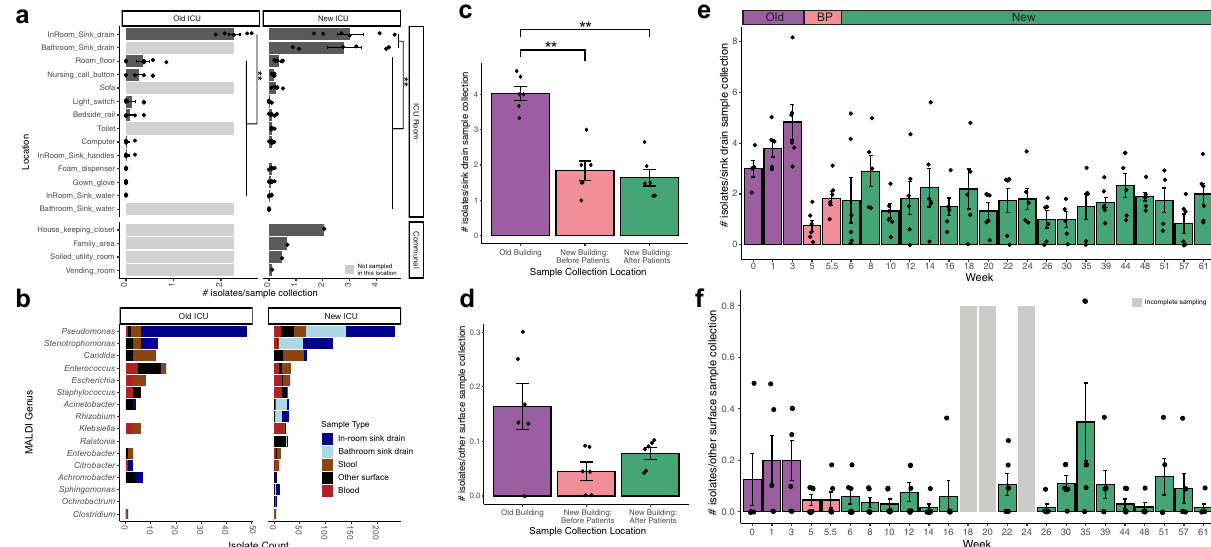
Fig. 2 Variation in isolate collection location, identity, and timing across all sampling. Error bars indicate standard error of intensive care unit (ICU) rooms. ** indicates generalized linear mixed-modeling (GLMM) p -value <0.01. a In-room and bathroom sink drains have signi fi cantly more isolates per collection than other surface locations in both the old and new ICU buildings ( n = 566 surface isolates). Locations in light gray were not collected in old ICU. b Genus of matrix-assisted laser desorption/ionization-time of fl ight mass spectrometry (MALDI-TOF) species identi fi cation of all collected isolates in both the new and old ICU. Other Surface includes all other surfaces that are not in-room or bathroom sink drain. c Variation in number of isolates collected per bathroom or in-room sink drain sample collection by building (excludes fecal and communal samples, n = 429). d Variation in number of isolates per other surface sample collection by building (excludes sink drain, fecal, and communal samples, n = 137). e Variation in number of isolates per bathroom or in-room sink drain sample collection for all time points, n = 429. f Variation in number of isolates collected per other surface sample collection across all time points (excludes sink drain, fecal, and communal samples, n = 137). Gray bars indicate weeks with incomplete sampling of surfaces. BP before patient and staff